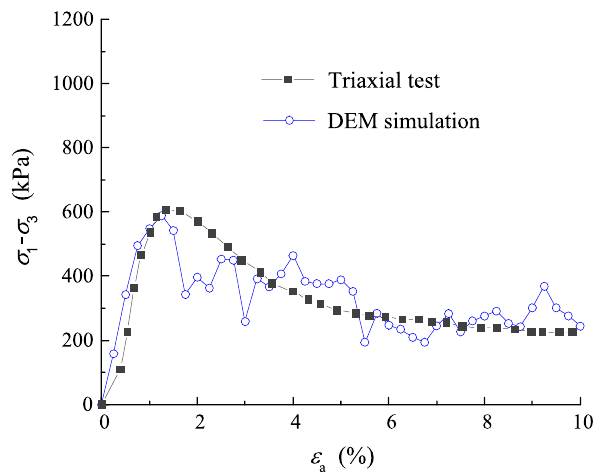
Figure 12. Comparison of DEM-simulated stress–strain curve with the measured one in triaxial test.